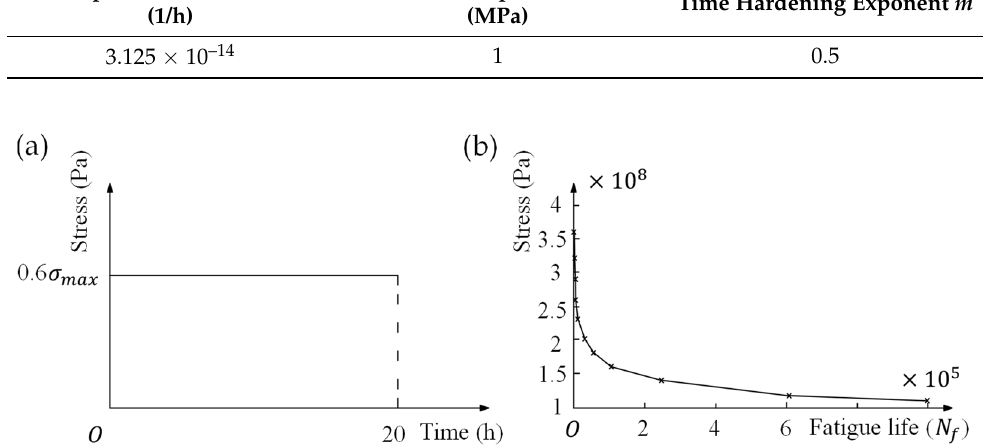
Figure 7. ( a ) Step load applied for the creep simulation; ( b ) S–N curve of alloy steel used.